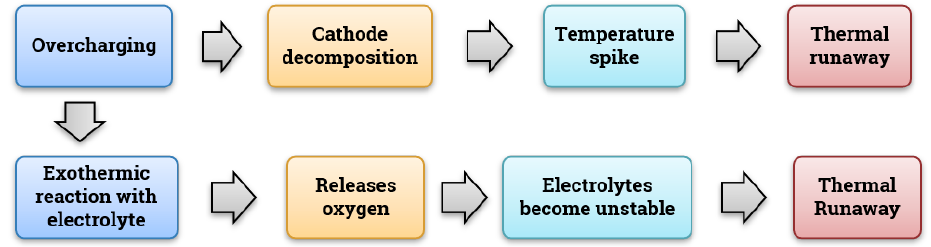
Figure 5. The possible failure mechanism of the cathode.